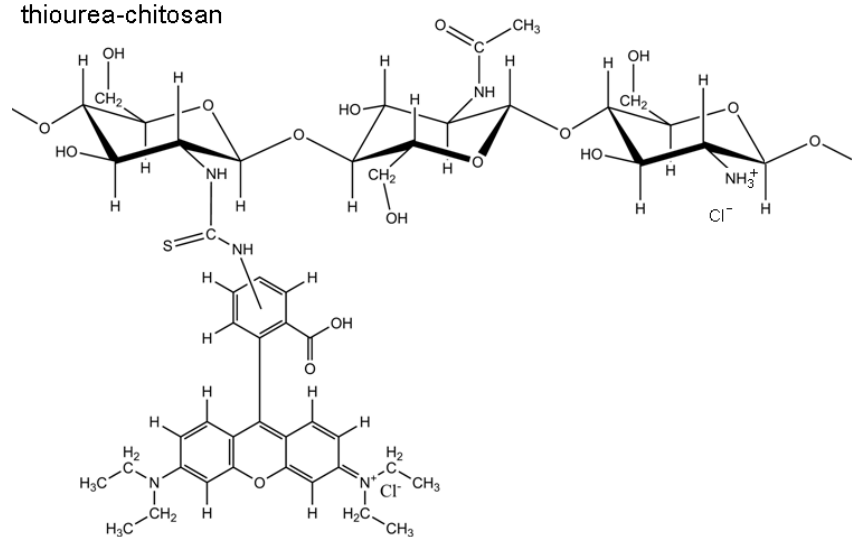
Figure 2. Chemical structure of